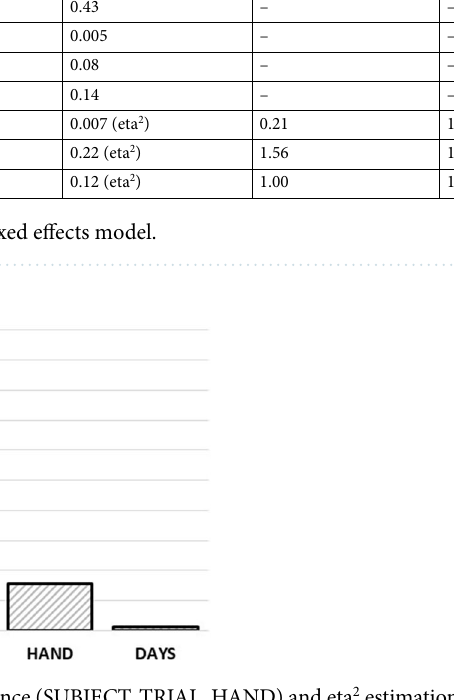
Figure 3. Comparison of explained variance (SUBJECT, TRIAL, HAND) and eta 2 estimations (DAYS, EDSS, EDSS:LAT).